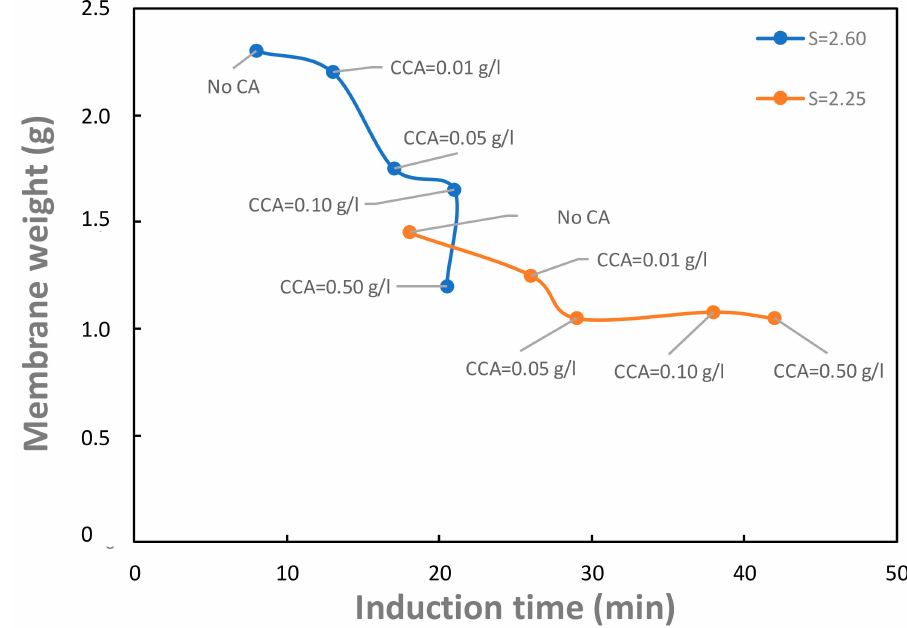
Figure 7. Membrane weight as a function of induction times for di ff erent citric acid